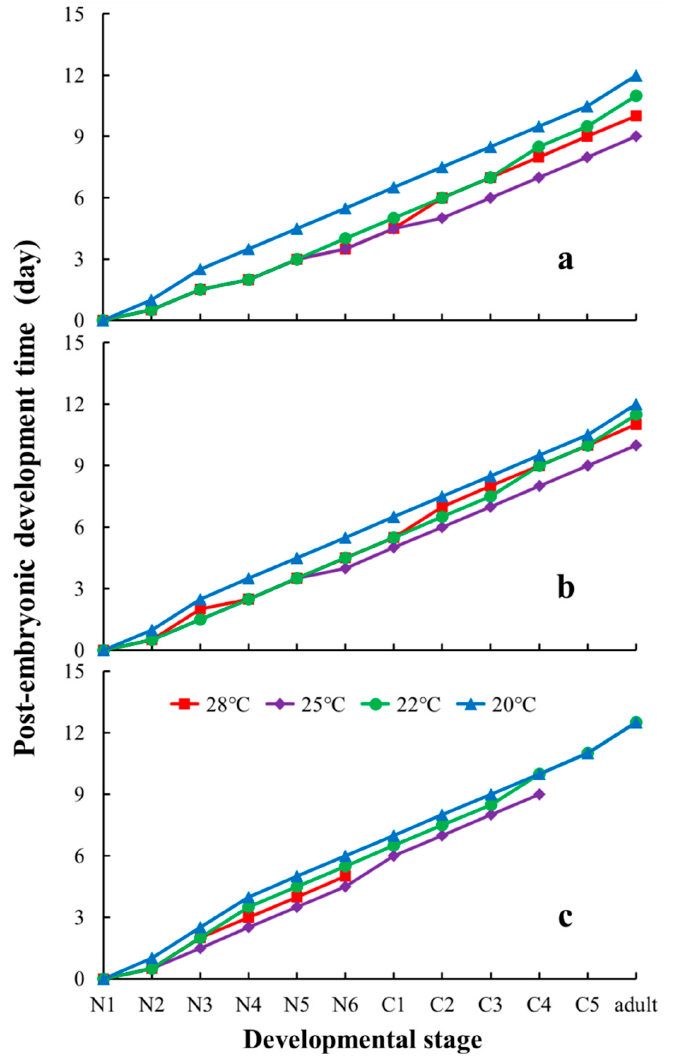
Figure 6. Post-embryonic development of Acartia bifilosa under different seawater temperatures (20, 22, 25, and 28 °C) and Chl a concentrations ( a ): 15 μ g/L, ( b ): 10 μ g/L, ( c ): 5 μ g/L).